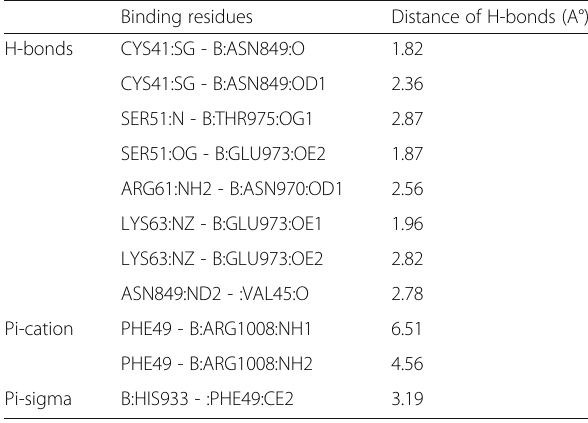
Table 4 Intermolecular interactions between Rab39a and natural substrate Binding residues Distance of H-bonds